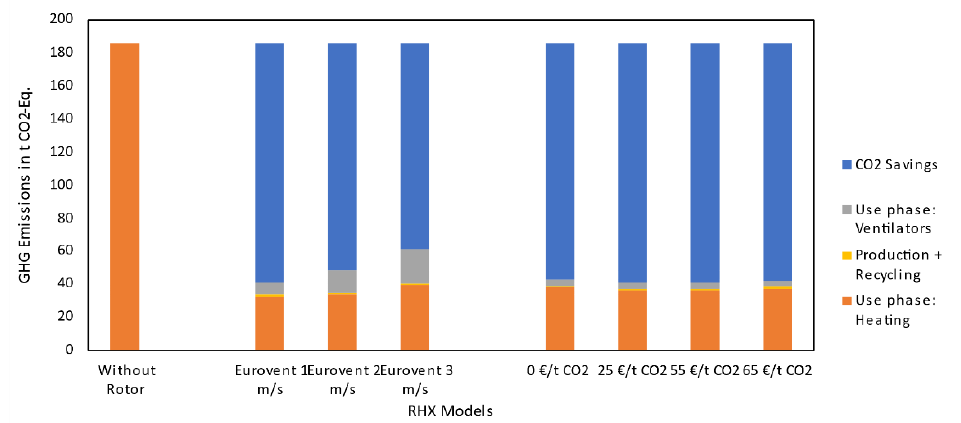
Figure 5. Total life cycle GHG emissions in CO 2 Eq. for different optimized RHXs and the Eurovent model at an FU of 10,000 m 3 /h.